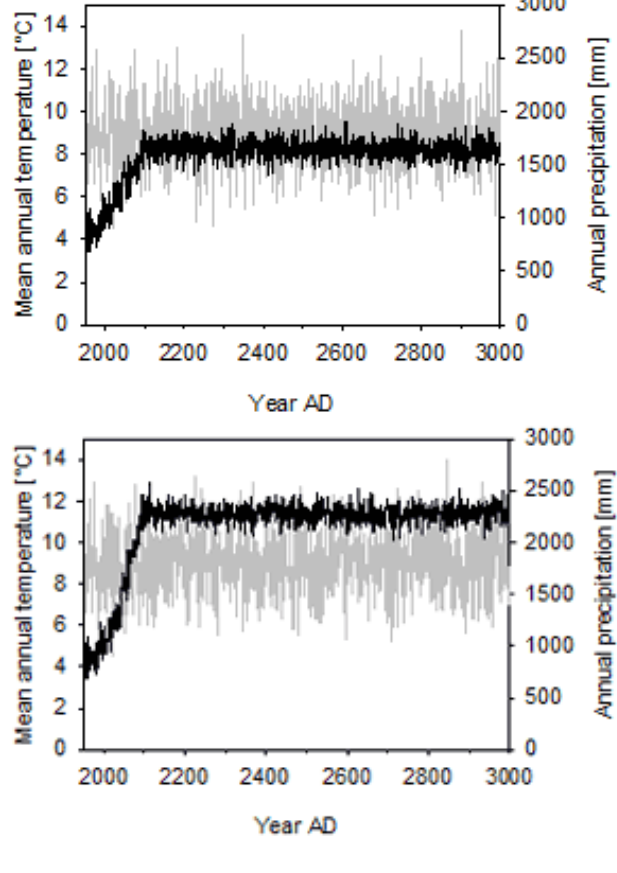
Fig. 3 . Climate time series (mean annual temperatures and annual precipitation) for the two emission scenarios starting in 2000 and ending in 2100 (B2 left, A1FI right). Temperature: black; precipitation: grey. After 2100, a stochastic climate time series was generated based on the temperature and precipitation means of the 2091–2100 period of each scenario and corresponding standard